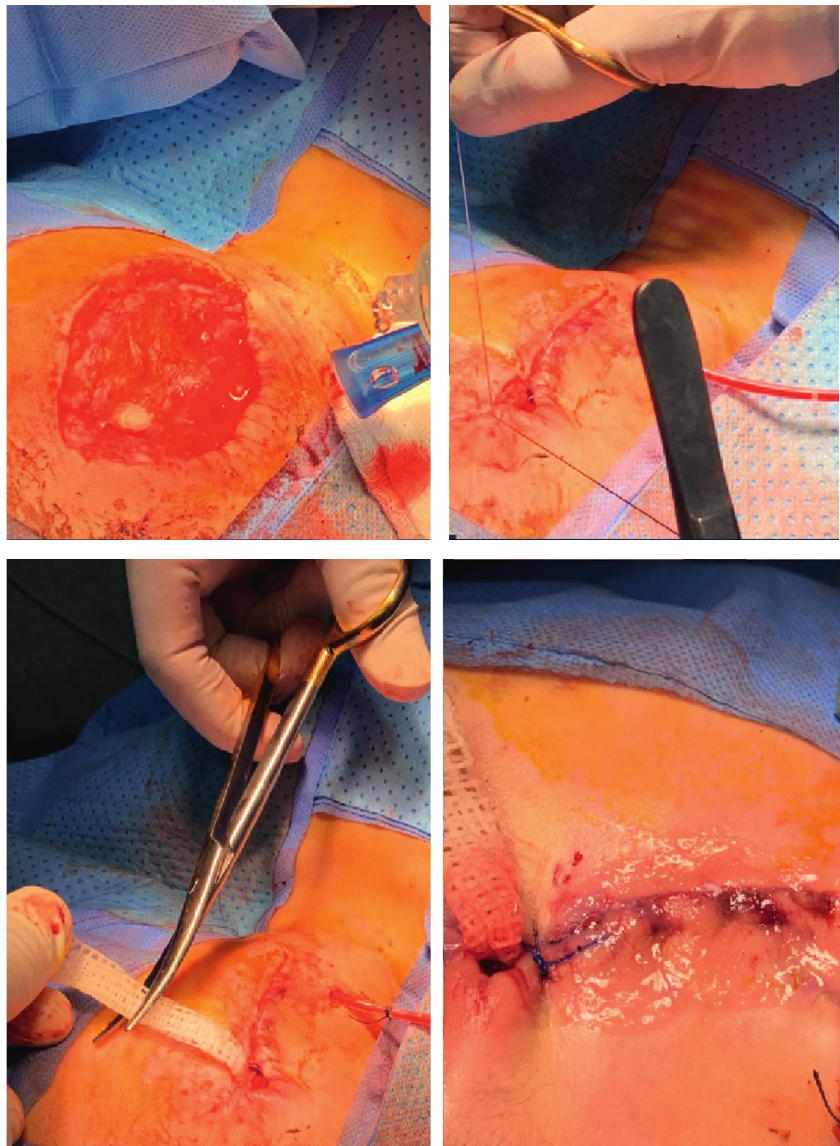
Figure 6: Intraoperative wound closure with pack and drains